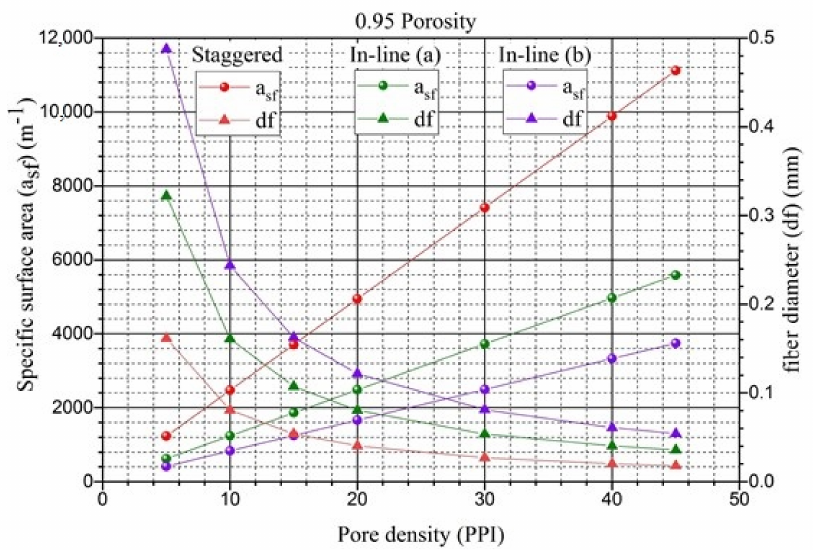
Figure 15. Variation of specific surface area of stacked wire-mesh porous media comprising of wire-mesh screens of various mesh size or pore density (pores per inch/mesh per